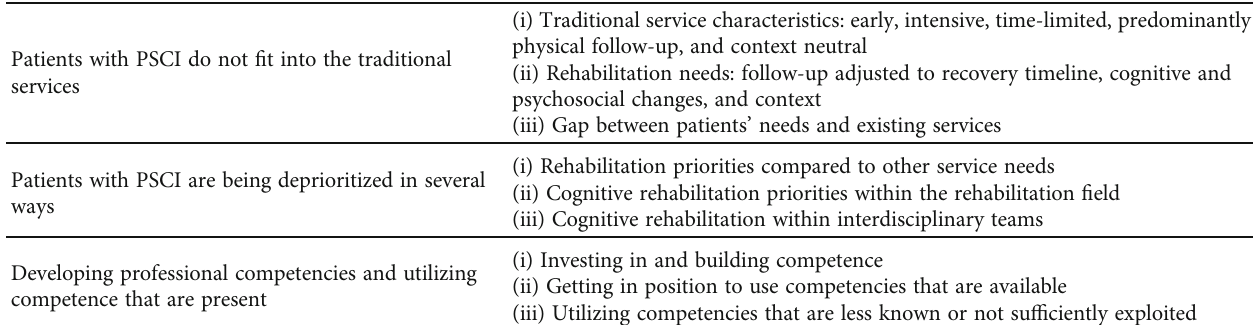
Table 1: Overview of results.